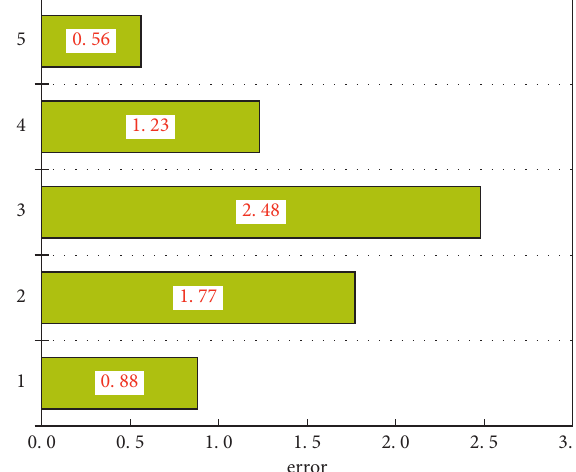
Figure 3: The classification results of company financial data through the XGBoost method.